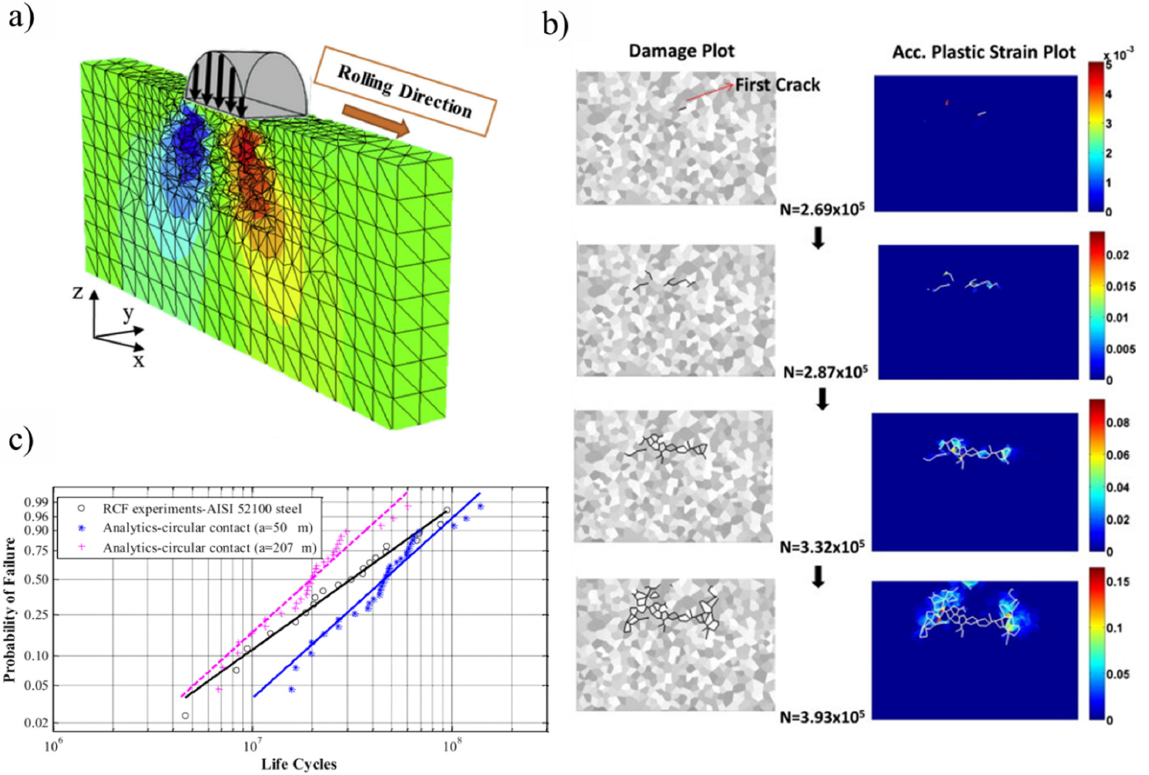
Figure 8. ( a ) A CDM 3D microstructure topology model with Voronoi tessellation; ( b ) crack evolu- tion with the accumulation of plastic strains; ( c ) Weibull probability plots of experimental and ana- lytical results